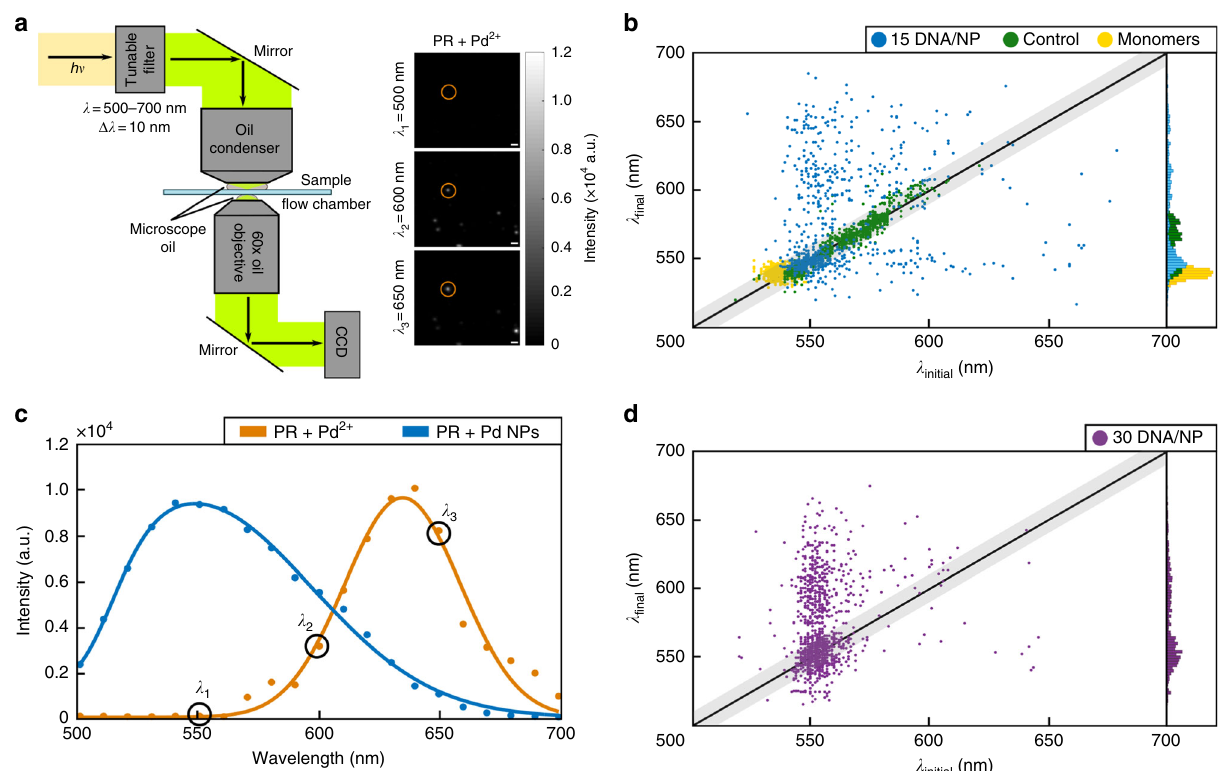
Fig. 3 Hyperspectral imaging of Pd 2 + loaded PRs before and after reduction. a Schematic overview of hyperspectral dark fi eld imaging set-up with representation CCD images for λ = 550, 600 and 650 nm. Images are magni fi ed sub-sections of a larger fi eld of view (scale bar = 20 μ m). The spectrum of the circled scatterer is shown in ( c ). b Plot of the plasmon resonance after Pd 2 + reduction ( λ fi nal ) as a function of resonance wavelength before Pd 2 + reduction ( λ initial ) for 1031 individual PRs with 15 DNA/NP (blue). λ initial and λ fi nal for control PRs (identical treatment but without Pd 2 + ) and NP monomers are included in green and yellow, respectively. The inset contains the distribution of λ fi nal . c Exemplary hyperspectral data for an individual PR with 15 DNA/ NP whose plasmon resonance blue-shifts upon Pd NP formation. d Plot of the plasmon resonance after Pd 2 + reduction ( λ fi nal ) as function of resonance wavelength before Pd 2 + reduction ( λ initial ) for 1056 individual PRs with 30